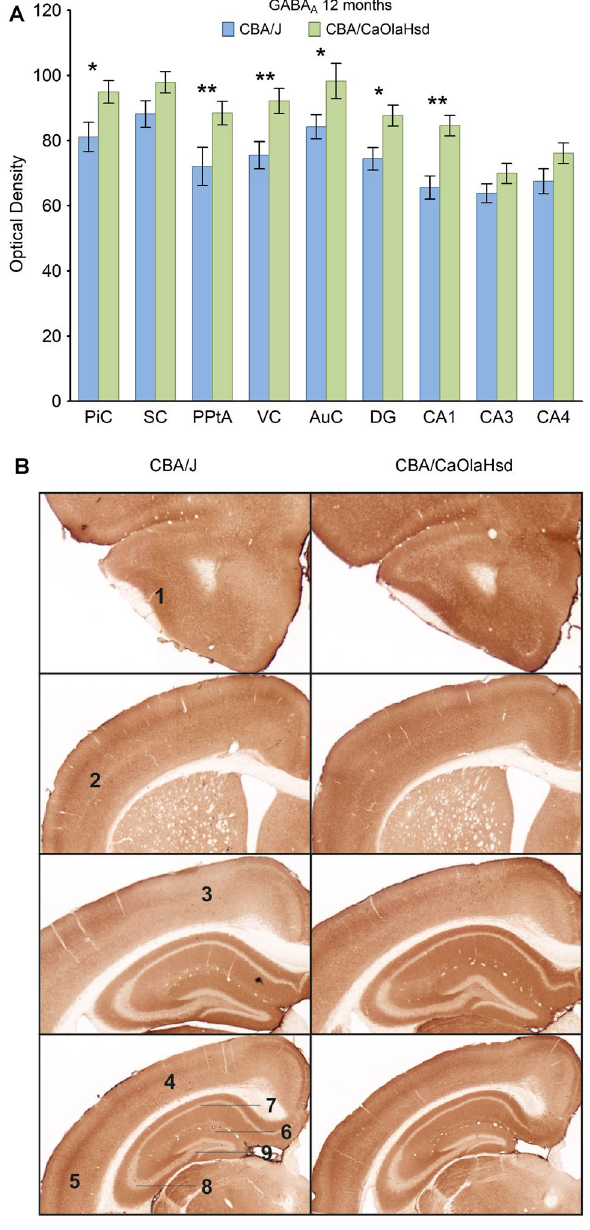
Figure 5. GABA A expression is differentially expressed in blind mice compared to CBA/CaOlaHsd mice 12 months postnatally. ( A ) Bar charts represent mean GABA A receptor optical densities in different brain regions 12 months postnatally in CBA/J (blind) compared to CBA/CaOlaHsd mice. Receptor density is significantly reduced in all areas except CA3 and CA4 in CBA/J mice. *P < 0.05; **P < 0.01; ***P < 0.001. ( B ) DAB-stained coronary sections showing GABA A expression in CBA/J compared to CBA/CaOlaHsd mice 12 months postnatally. The photomicrographs highlight the changes as described in ( A ). 1: piriform cortex, 2: somatosensory cortex, 3: posterior parietal cortex, 4: visual cortex, 5: auditory cortex, 6: dentate gyrus, 7: CA1, 8: CA3, 9: